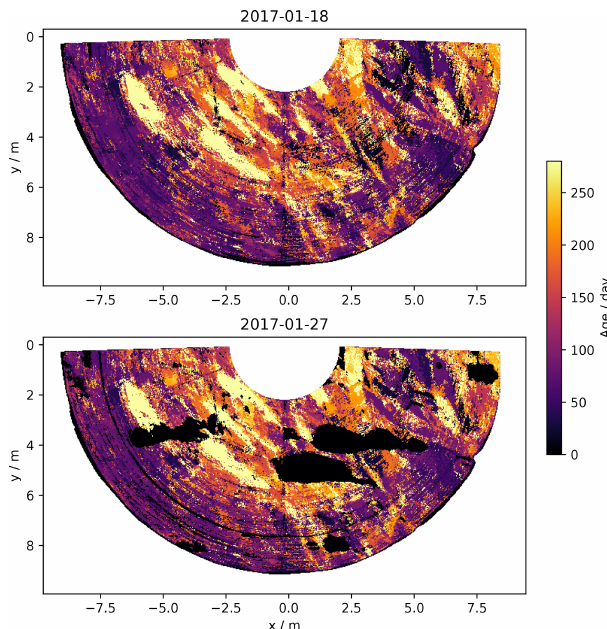
Figure 11. Map of age of the snow on the surface for two dates.